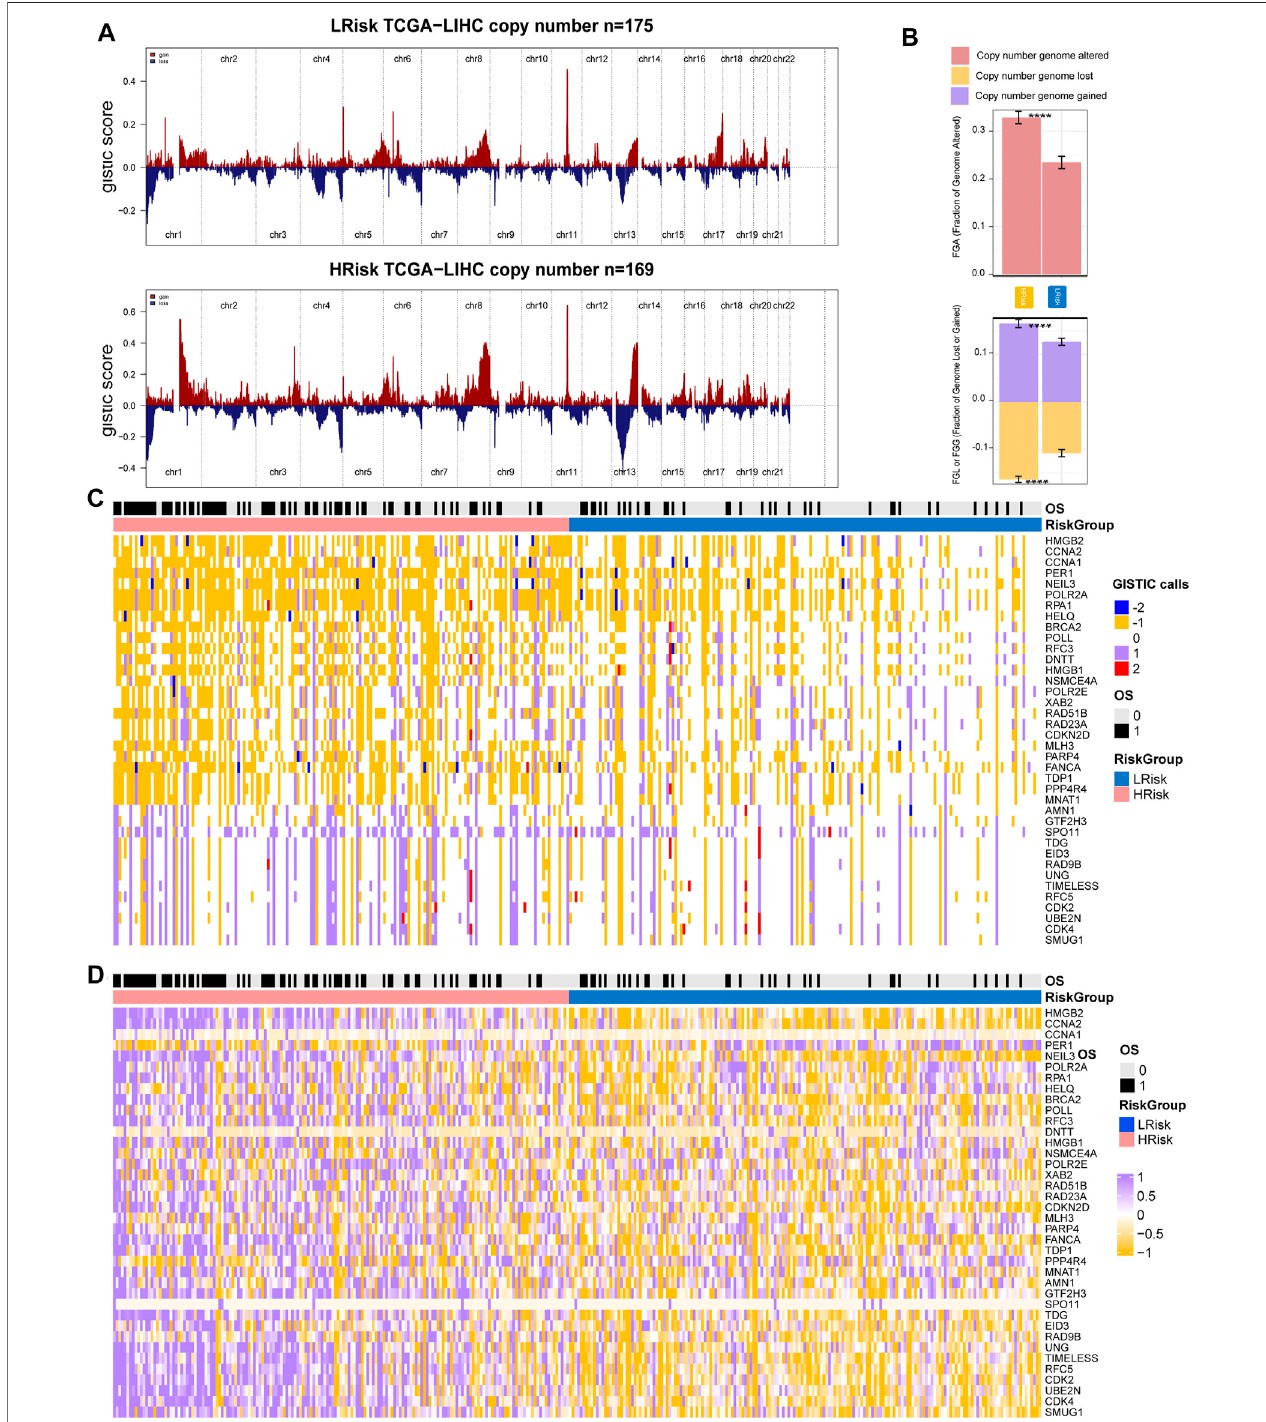
FIGURE8| Integrativeanalysisofcopynumberalterationandgeneexpressionpro fi ling. (A) Copynumbergainsanddeletionsidenti fi edbyGISTIC2.0inHRiskand LRisk. (B) Distribution of fraction genome altered (FGA) and fraction genome loss/gain (FGG/FGL). Bar charts are presented as the mean ± standard error of the mean. (C) Heatmap of GISTIC calls of 38 DDR genes. (D) Heatmap showing the overexpression pattern of 38 DDR genes.